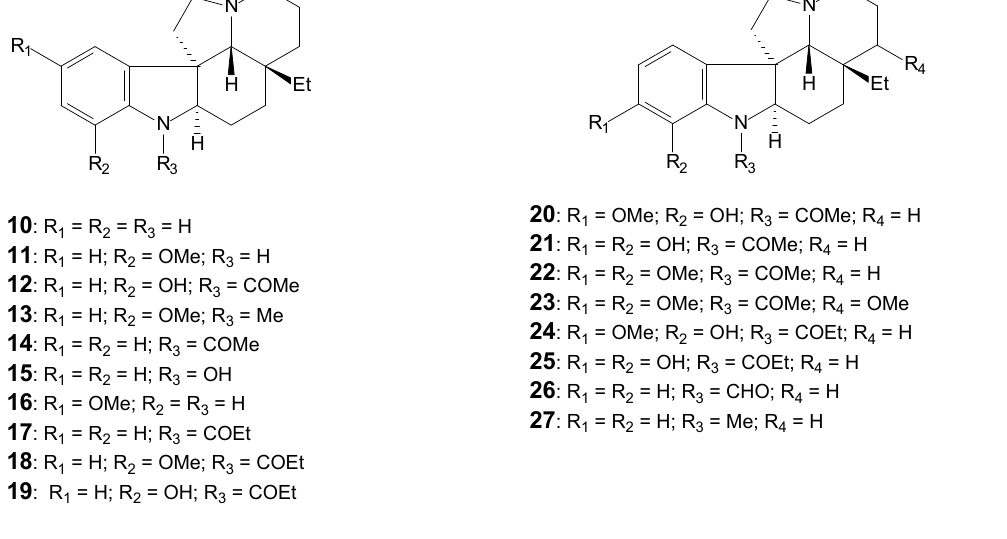
Figure 5. Plumeran indole alkaloids: Limaspermine ( 28 to 35 ) and Cylindrocarine ( 36 to 46 ) skeletons